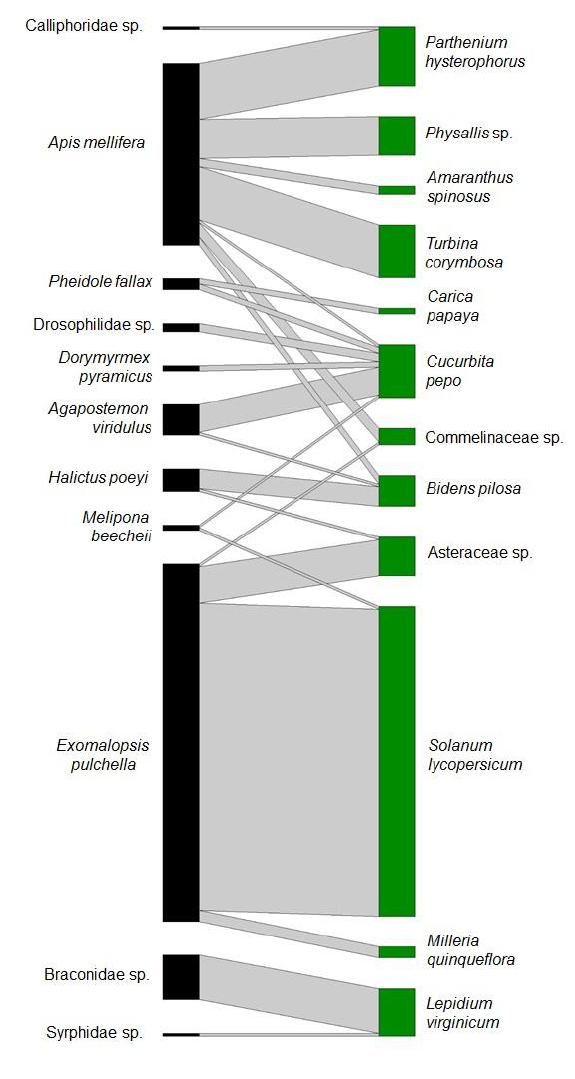
Figure 2. Pollination network around tomato fields in agroecosystems of Mayabeque, Cuba, between November 2018 and March 2019. Floral visitors are depicted in black squares, plants in green squares and interactions in grey lines between them. The thickness of grey lines indicates the abundance of every